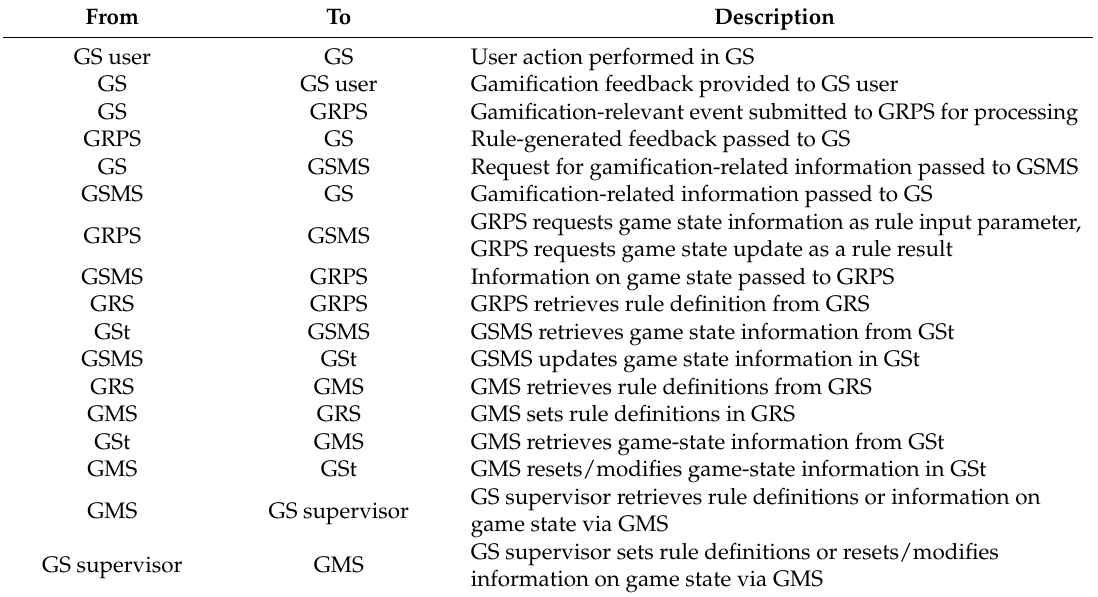
Table 1. The character of interactions between gamification system components and